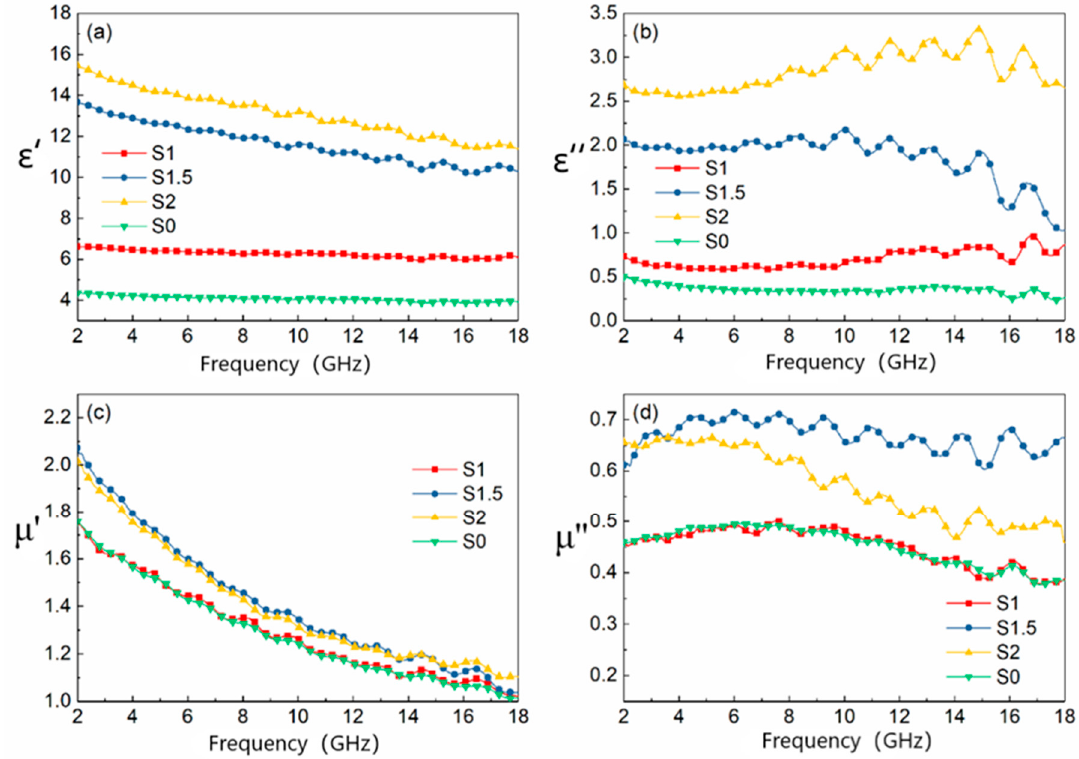
Figure 1. Electromagnetic parameters of four samples. ( a ) Real part of permittivity; ( b ) imaginary part of permittivity; ( c ) real part of permeability; ( d ) imaginary part of permeability.